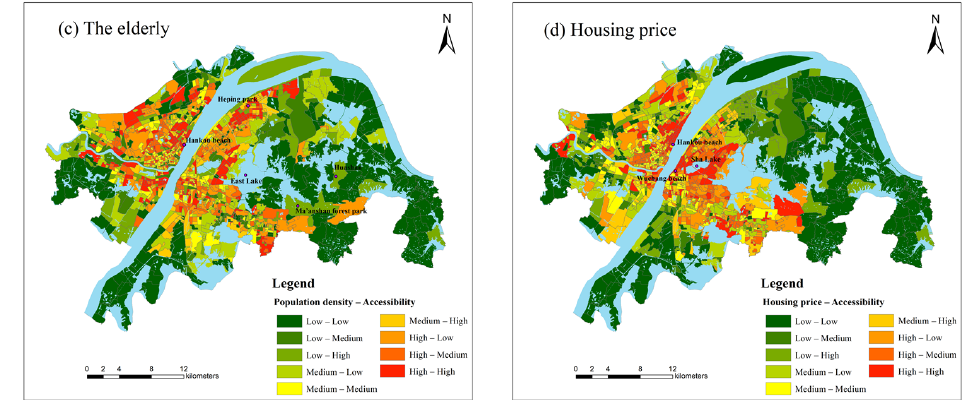
Figure 5. The matching of population density, housing price and park green space accessibility: ( a ) youth, ( b ) young and middle – aged, ( c ) the elderly and ( d ) housing price.